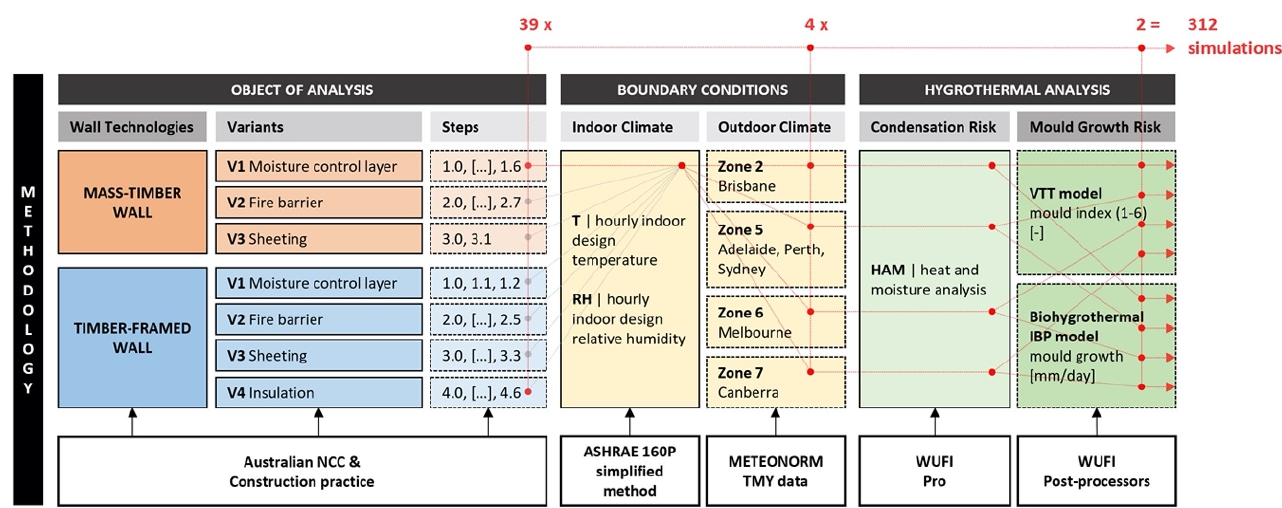
Figure 2. Visual representation of the combinations of the various parameters used in the analysis to generate the scenarios. The red lines indicate how these parameters (wall technology, variants, indoor and outdoor climates, post-processing) are combined to reach the final simulation matrix.